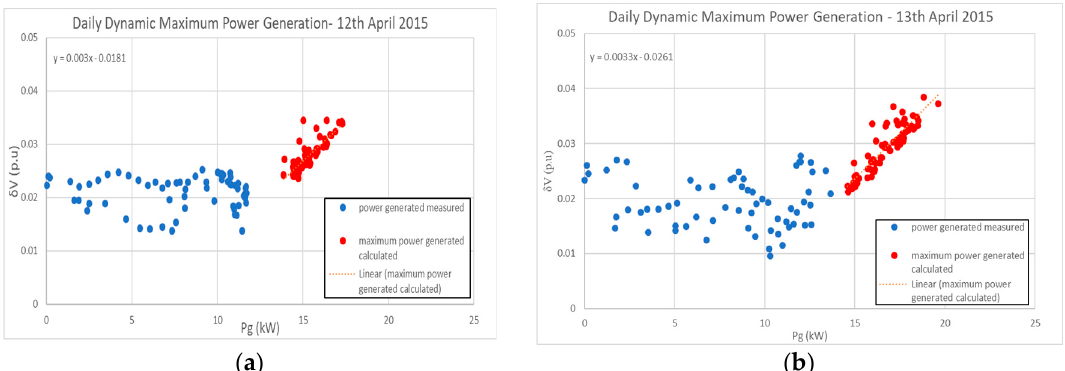
Figure 5. Voltage variation x generated power and the linear dependency in relation to the maximum amount of power calculated by Equation (5) for 10th of April 2015 and 11th of April 2015.